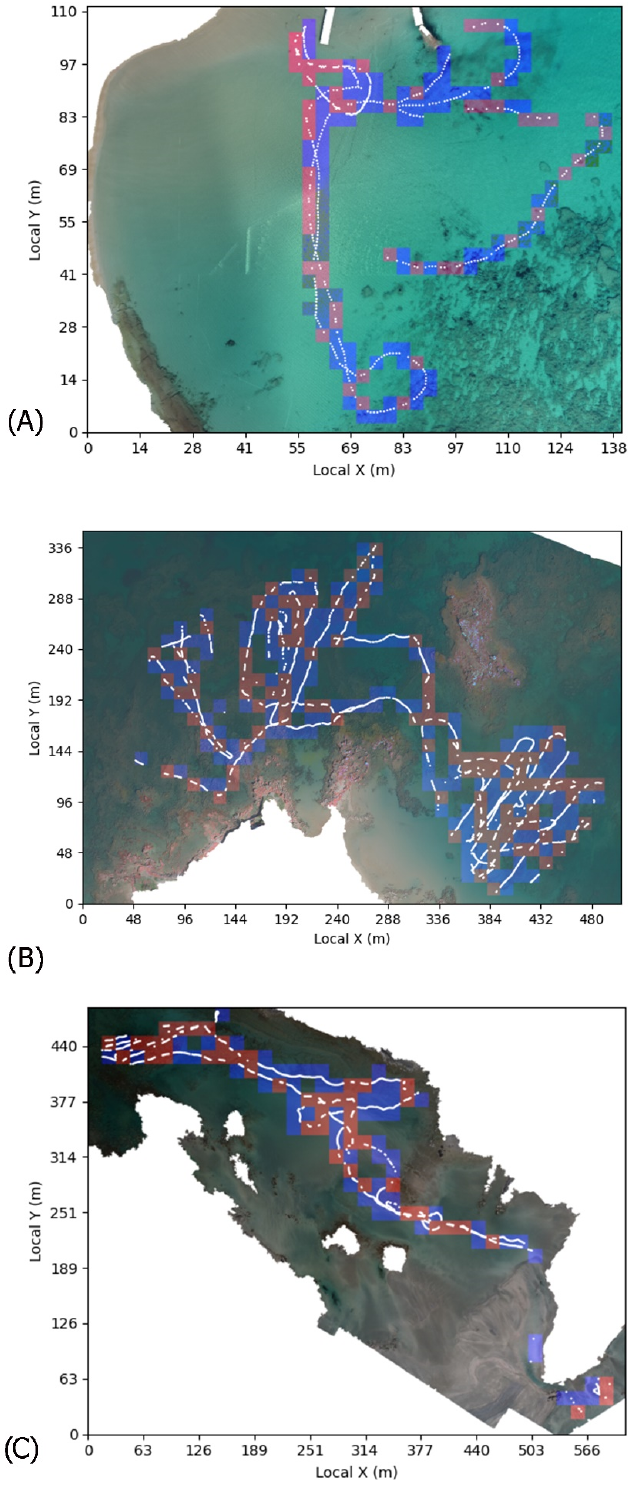
Figure 4. Training (blue) and test (red) split of tiles/patches used by the CNN model for each study area. The presented train/test split uses the ratio 60/40 of the tiles that contain USV measurements (white dots). ( A ) Stavros bay, ( B ) Kalamaki beach, ( C ) Elafonisi beach.